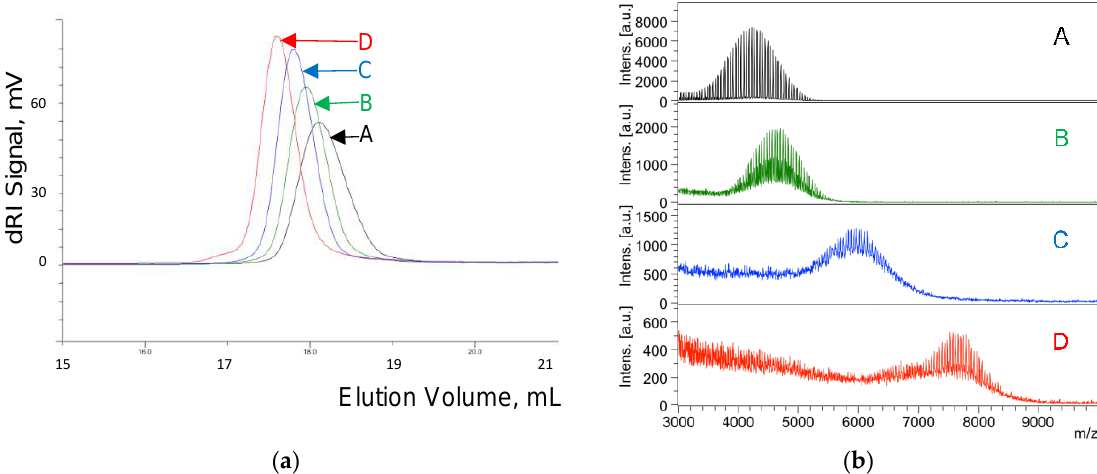
Figure 2. Analysis of starting material PEG 5k, A, intermediate (alkyne)-PEG5k-(alkyne), B, and final products (G1) 2 −PEG5k−(G1) 2 , C, (G2) 2 −PEG5k−(G2) 2 , D: ( a ) Overlay of SEC eluograms; ( b ) Overlay of MALDI-TOF spectra. See Sections 2.2.1 and 2.2.2. in Materials and Methods for analysis condi- tions.